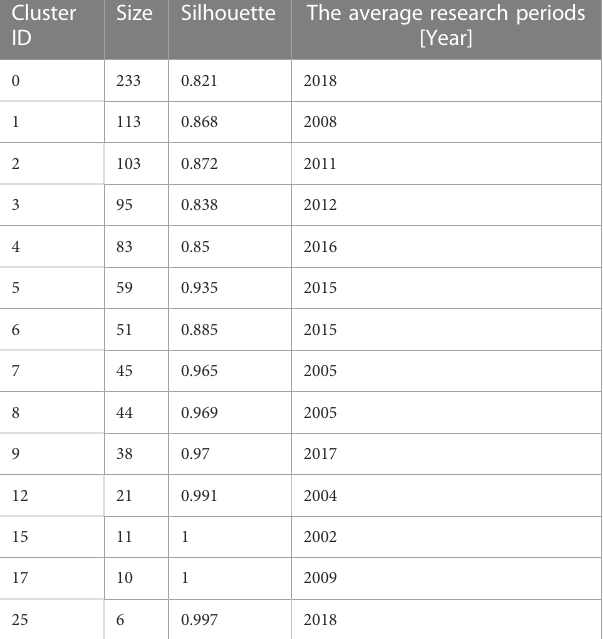
TABLE 4 Clustering information of the antioxidant capacity of the bioactive substances in microalgae. Cluster